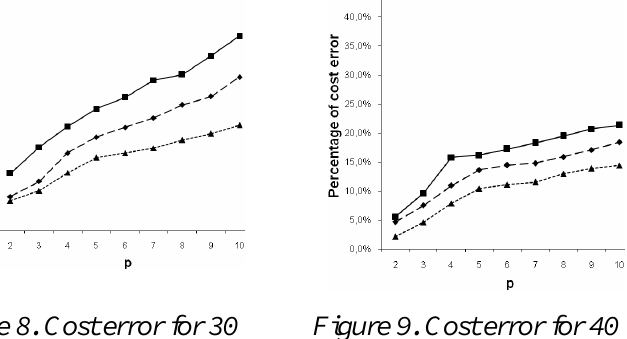
Figure 7. Cost error for 20 aggregated nodes.